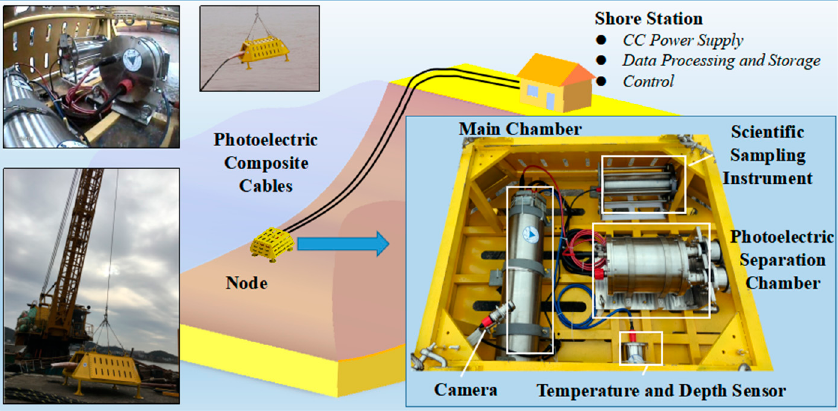
Figure 16. The observatory deployed off Zhairuo Island.